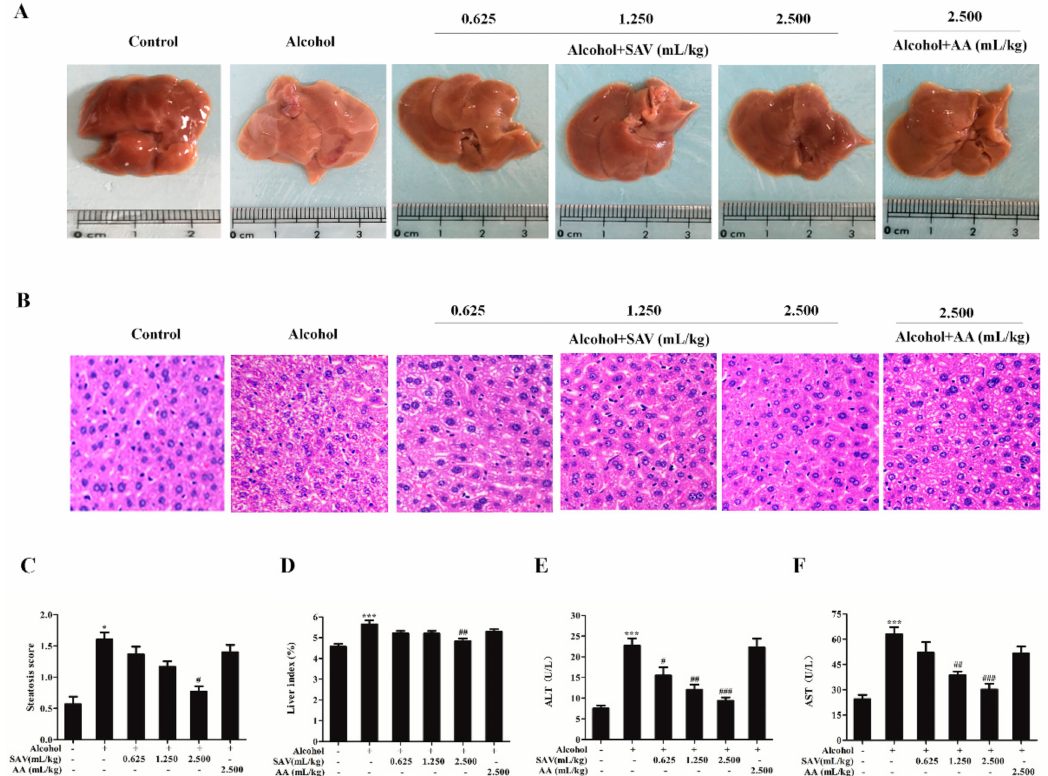
Figure 1. Effect of SAV on alcohol-induced liver injury. ( A ) Gross examination of mice livers; ( B ) Histological examination of liver sections stained with H&E. (200 × magnification); ( C ) Liver stestosis score; ( D ) the level of liver index. Serum levels of ALT ( E ) and AST ( F ) were measured with microplate reader. All data are expressed as mean ± SEM ( n = 5–7). * p < 0.05, *** p < 0.001 versus control group, # p < 0.05, ## p < 0.01, ### p < 0.001 versus ethanol